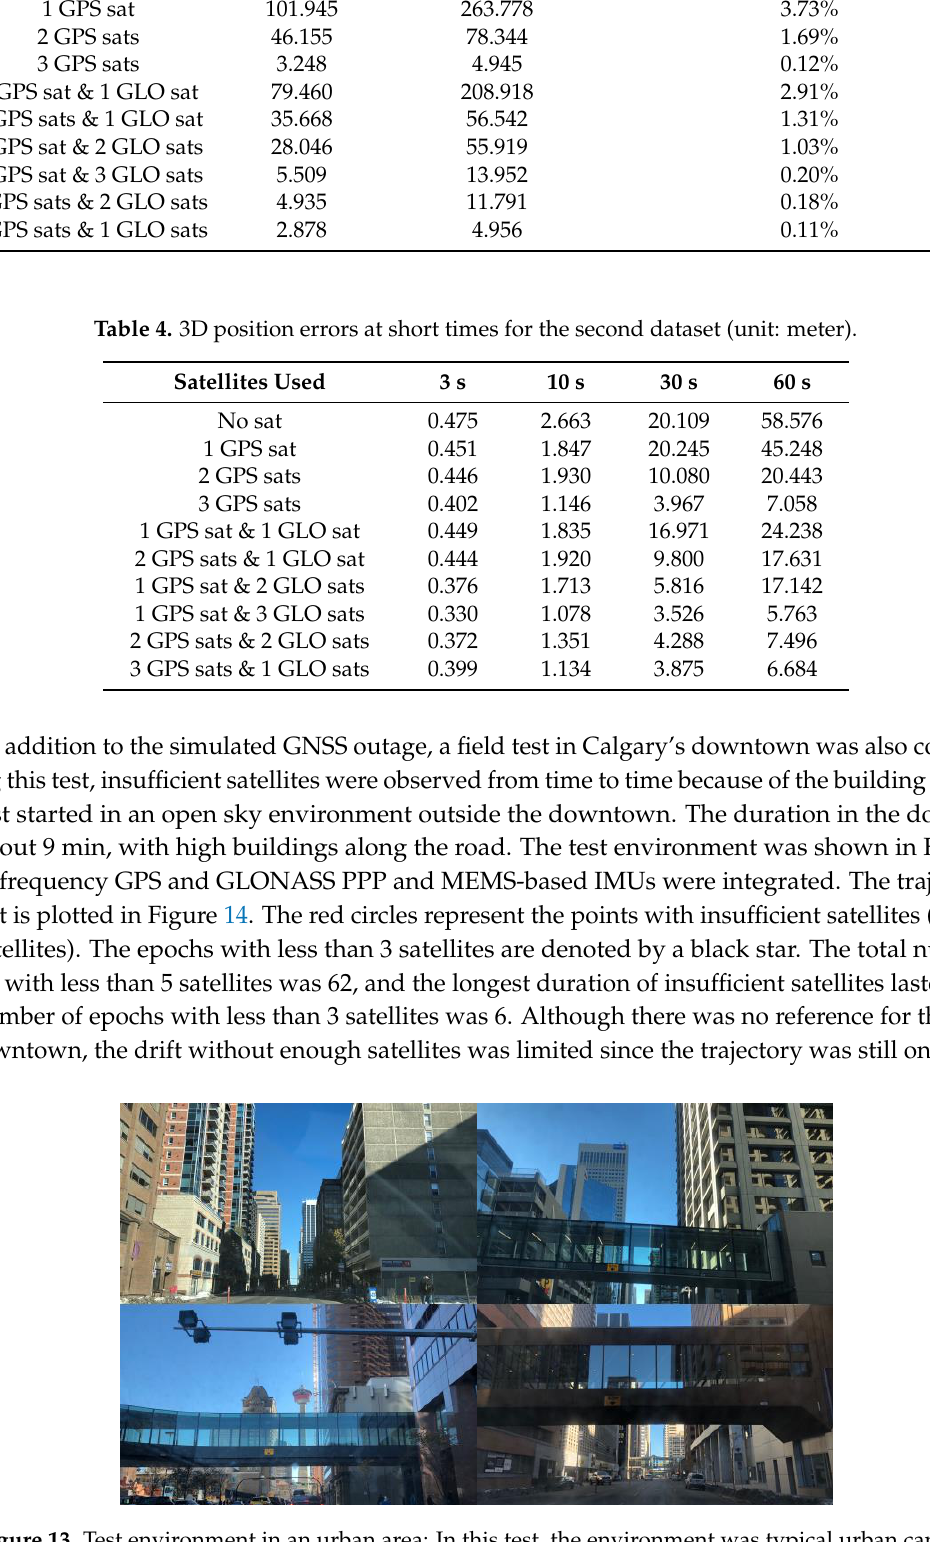
Figure 14. Test trajectory in Calgary ’s downtown. 5. Conclusions This paper implemented the tightly coupled single-frequency GNSS PPP/INS with NHC using a low-cost GNSS receiver and a MEMS-based IMU. The field results showed that in long-term GNSS outages (several minutes), the horizontal drift without GNSS could be limited to 200 m with movement close to 3 km. Generally, with more satellites used, the accuracy of solutions can be improved. When one satellite was used, the accuracy might not be improved, compared to no satellites used at all, because of no increase in measurement redundance. The distribution of the satellites affects the solution accuracy. Since the NHC provides velocity constraints in the right and up directions in the body frame, the accuracy can be improved with better estimation of forward velocity. Higher velocity is likely to generate worse results, comparing the two datasets. For both datasets collected, the horizontal accuracy could be reduced to a few meters with three GPS satellites applied. In short-term GNSS outages (less than one minute), the position errors were less than 1 m within 3 s. Generally, the 3D position accuracy was improved with more satellites used as well. The improvement was more evident with longer periods of GNSS outages. Within half a minute, most of